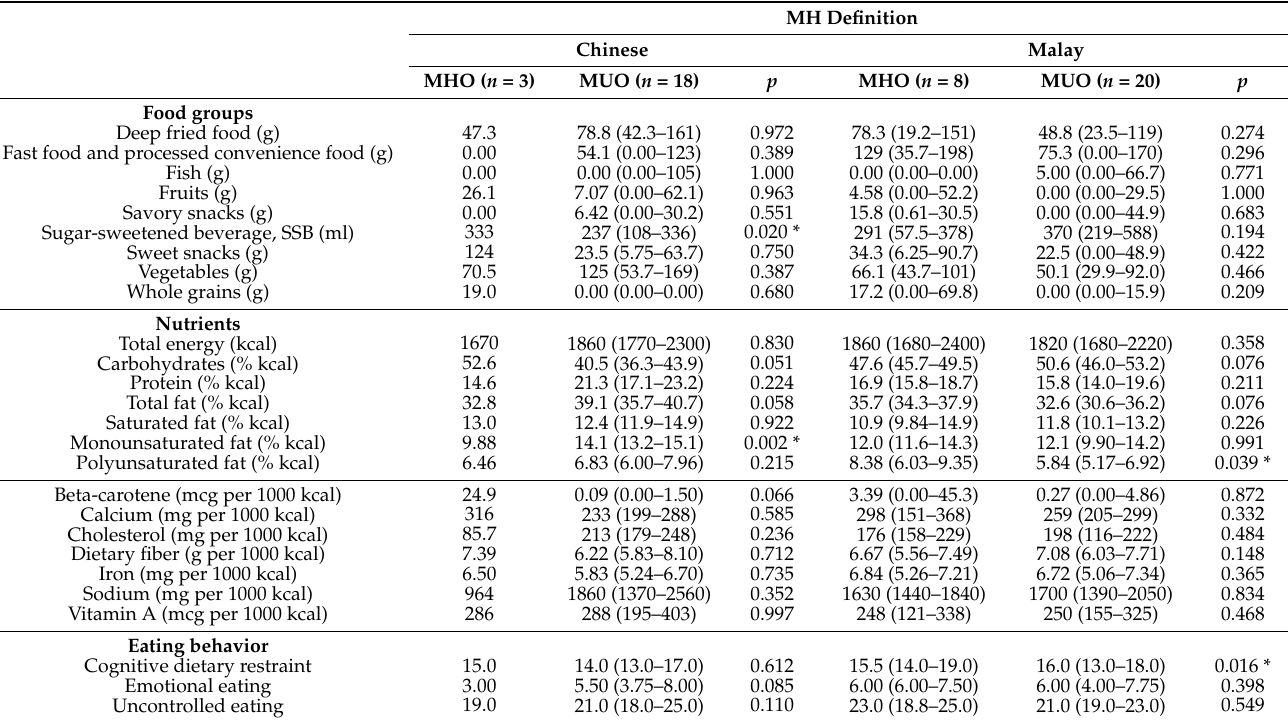
Table 4. Food groups, nutrient intakes and eating behavior between children/adolescents with MHO and children/adolescents with MUO (MH definition) stratified by